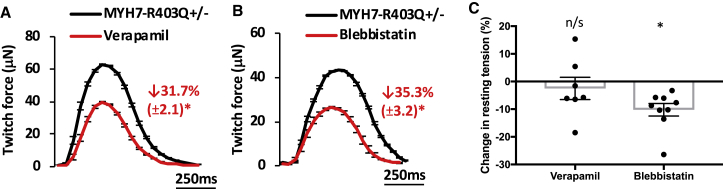
Reduction of Hypercontractility in MYH7-R403Q+/– Tissues by Small MoleculesRepresentative tracings and percentage change in twitch force for MYH7-R403Q+/– CMTs treated with carrier control (black tracing) compared with (A) verapamil (0.5 μM; red tracing) or (B) blebbistatin (10 μM; red tracing). (C) Comparison of the effects of verapamil and blebbistatin on resting tension in MYH7-R403Q+/– CMTs. Significance was assessed by Student's t test (A–C) (∗all p < 0.05); data are means ± SEM (error bars) (A–C). Each data point represents a single CMT (C) generated by at least three biological replicates by iPS differentiation batch.